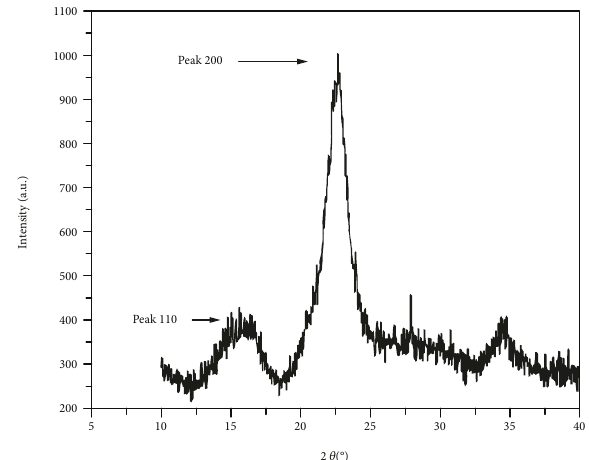
Figure 4: XRD spectra of cellulose prepared from the wood of Eucalyptus lenceolata .